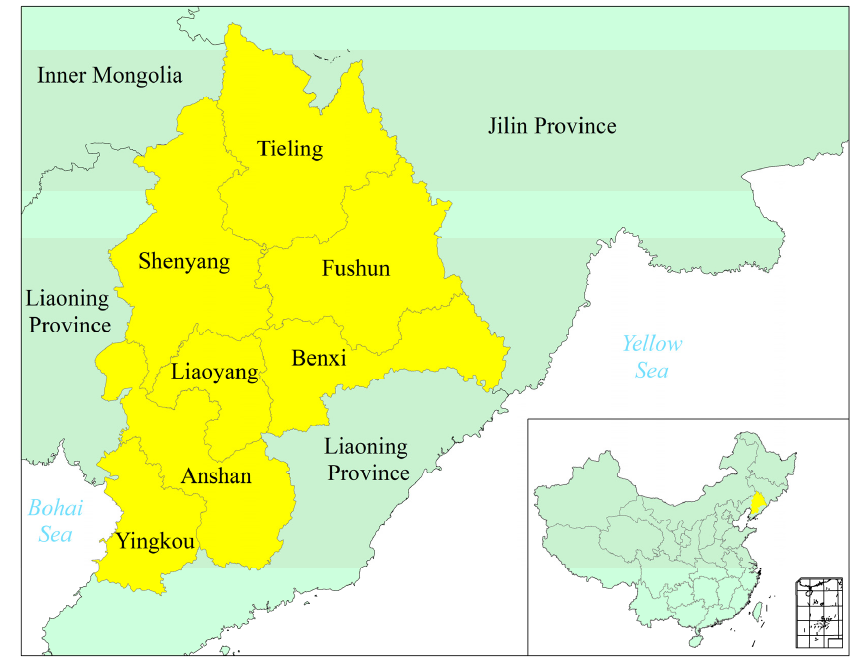
Figure 1. Location of China Central Liaoning urban